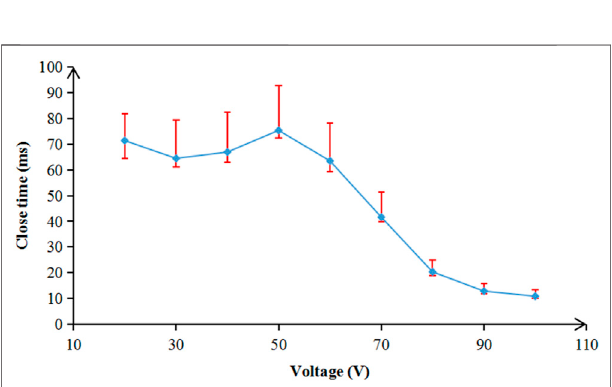
Frontiers in Physics |